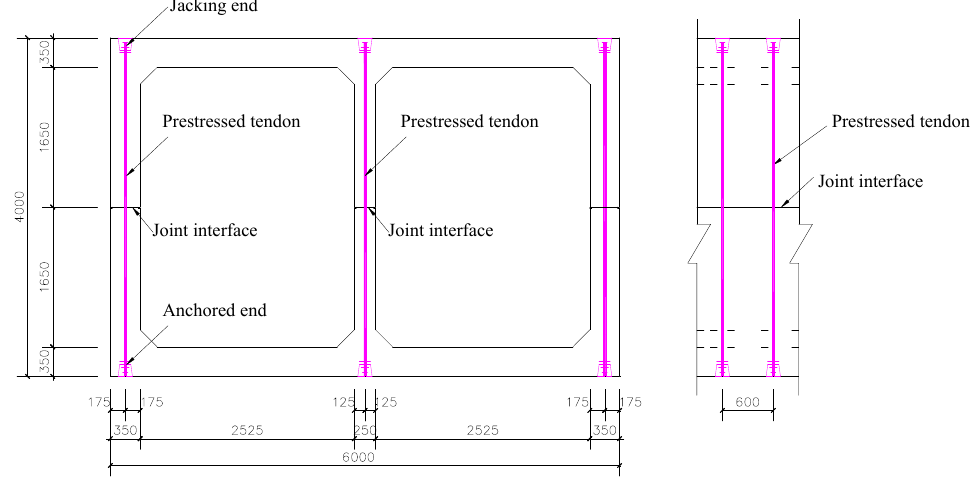
Figure 1. Cross-section of the double-cell PUTCGE (unit: mm).